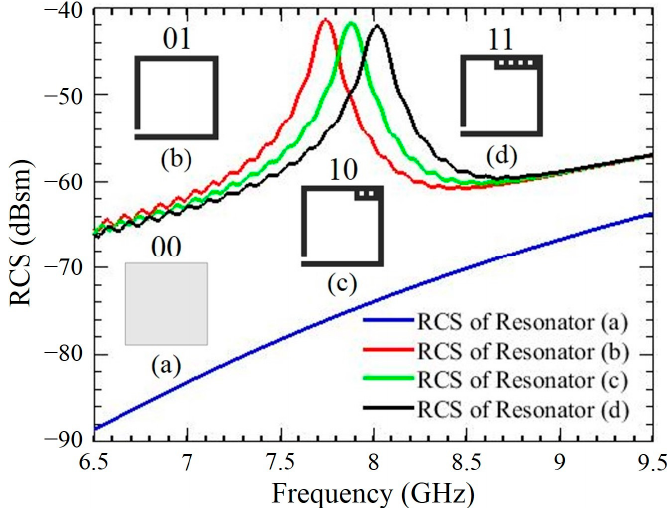
Figure 15. Simulated RCS response of intermediate loaded open-loop resonator.